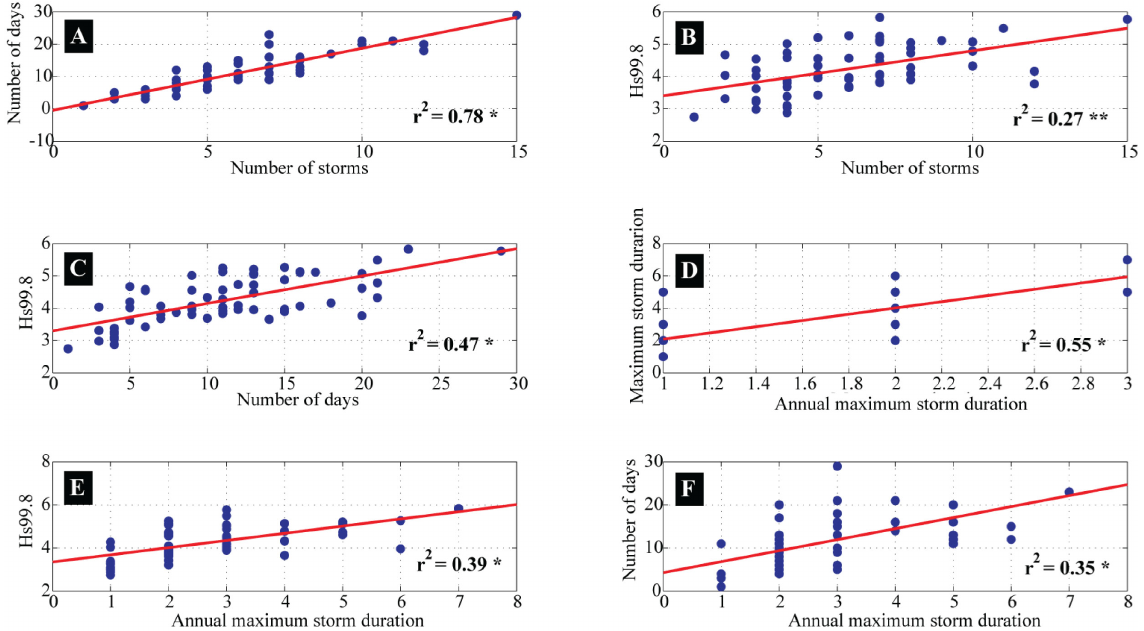
Fig. 5. Dispersion diagrams showing the correlations between storm parameters; (A) annual number of storms vs. annual number of days with storms; (B) annual number of storms vs. annual H s99 . 8 ; (C) annual number of days with storms vs. annual H s99 . 8 ; (D) annual maximum individual storm duration vs. annual mean individual storm duration; (E) annual maximum individual storm duration vs. annual H s99 . 8 ; (F) annual maximum individual storm duration vs. Annual number of days with storms. * significant for p < 0.01; ** significant for p < 0.05.